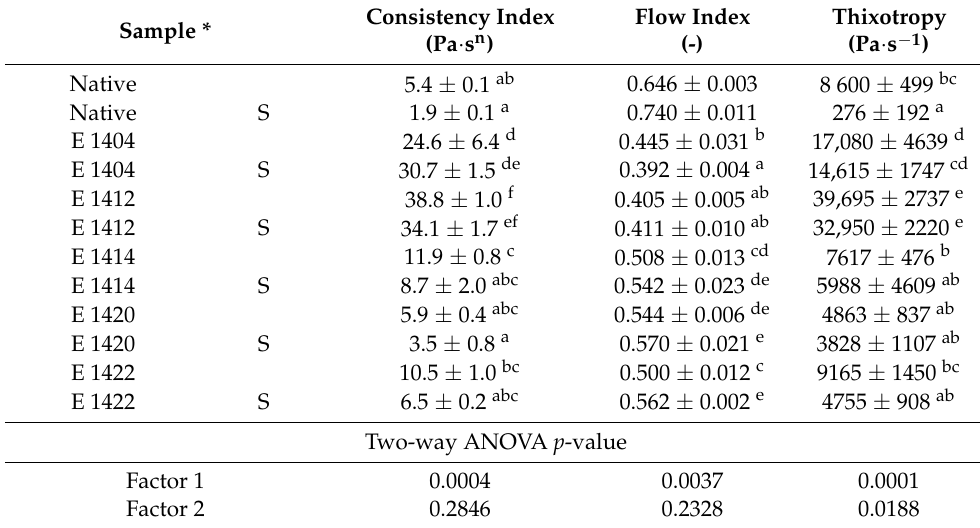
Table 2. Parameters describing flow behavior of modified starch